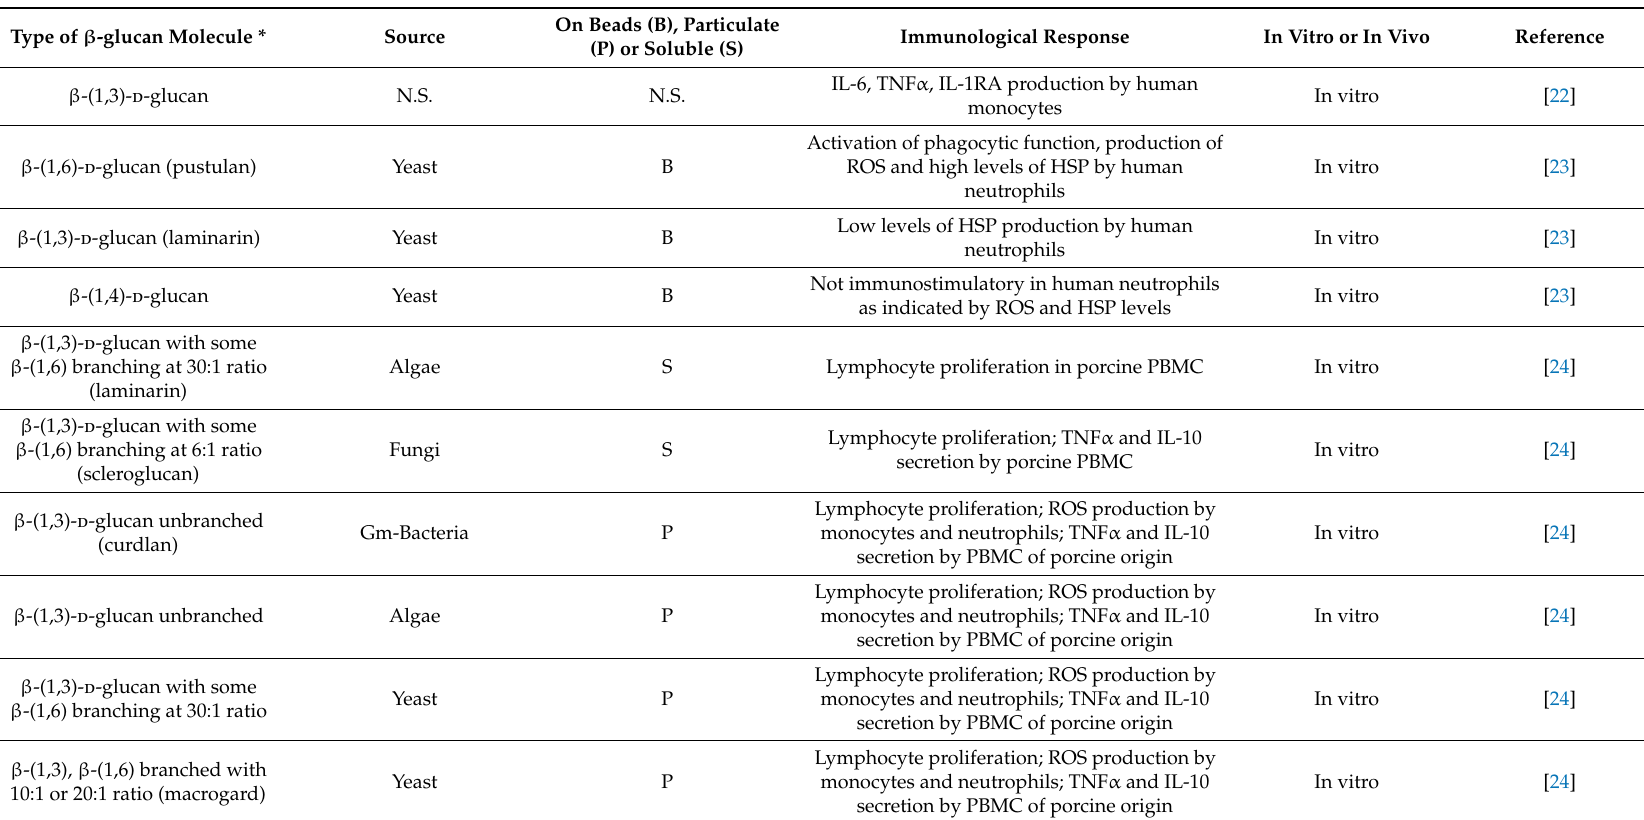
Table 1. Immunological properties of glucans from various sources. The table summarizes select examples from published studies demonstrating various types of immune responses to beta-glucans. * Whenever available, a common name is provided in parentheses. ROS = reactive oxygen species; HSP = heat shock